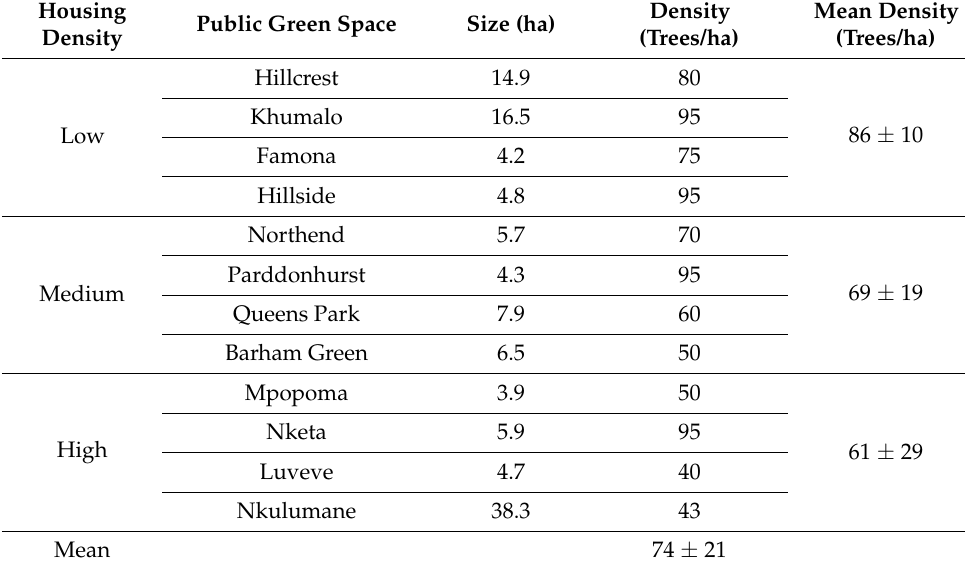
Table 1. Tree density in public parks in Bulawayo across three residential housing density areas.